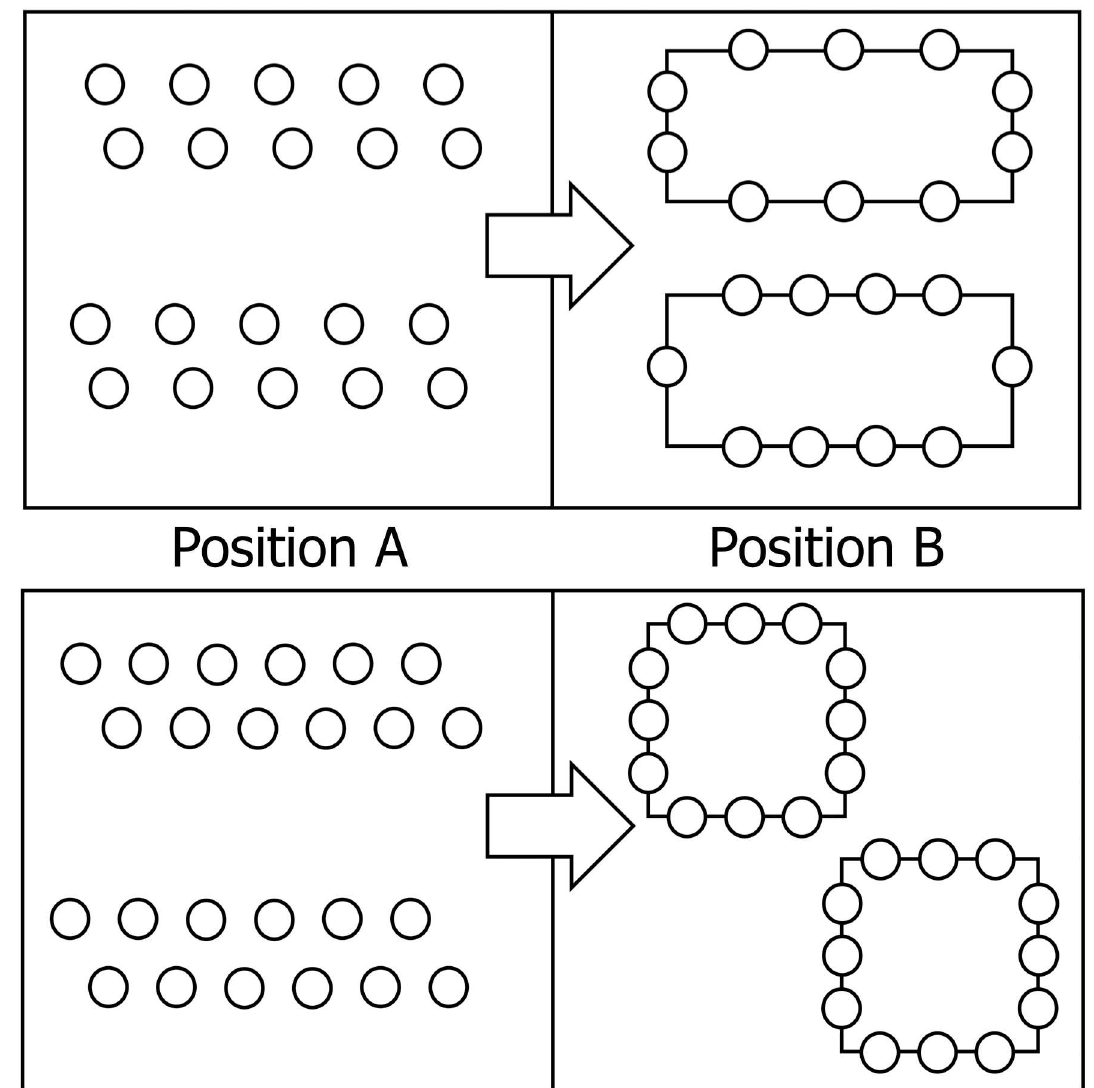
as the above-mentioned analysis, Bartlett’s test of homogeneity of variance was also used. Effect sizes for F-statistics were expressed as partial eta squared ( η p2 ) values. The type one error was set as α = 0.05. For the processing of results, we used the data analysis software sys- tem Statistica v. 13.2 for Windows (Dell Inc., Tulsa, OK, USA).